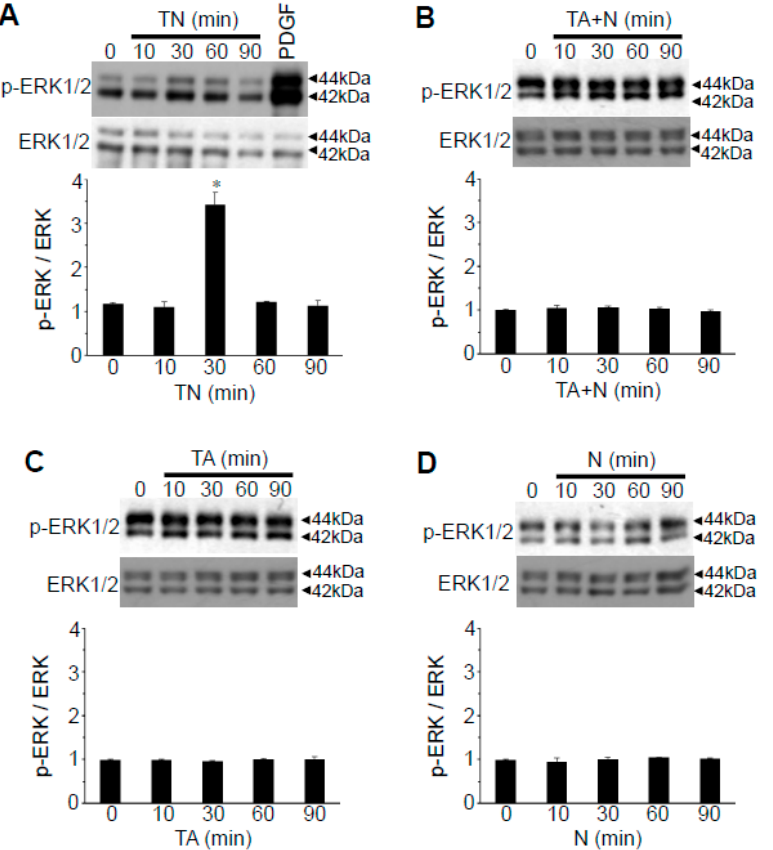
Figure 6. TN activates extracellular signal regulated kinase (ERK) mitogen-activated protein (MAP) kinase. ( A ) Human pulmonary artery smooth muscle cells were treated with TN (100 μ M) for the durations indicated or with platelet-derived growth factor (PDGF; 10 ng/mL) for 10 min as a positive control. Cell lysates were subjected to Western blotting for phosphorylated ERK1/2 (p-ERK) and ERK1/2 protein. The bar graph represents the means +/ − SEM of the p-ERK/ERK ratio. * Significantly different from control at p < 0.05 ( n = 4). ( B – D ) Cells were treated with either TA (100 μ M) plus niacin (100 μ M; TA + N), TA (100 μ M), or niacin (100 μ M; N) for the durations indicated. Cell lysates were subjected to Western blotting for phosphorylated ERK (p-ERK) and ERK1/2 protein. The bar graph represents the means +/ − SEM of p-ERK/ERK ratio. Values are not significantly different.